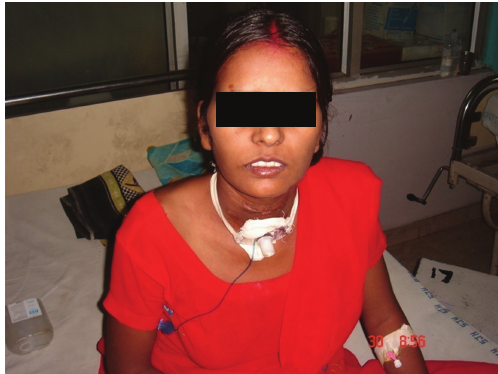
Figure 4: Photograph of the patient at the time of